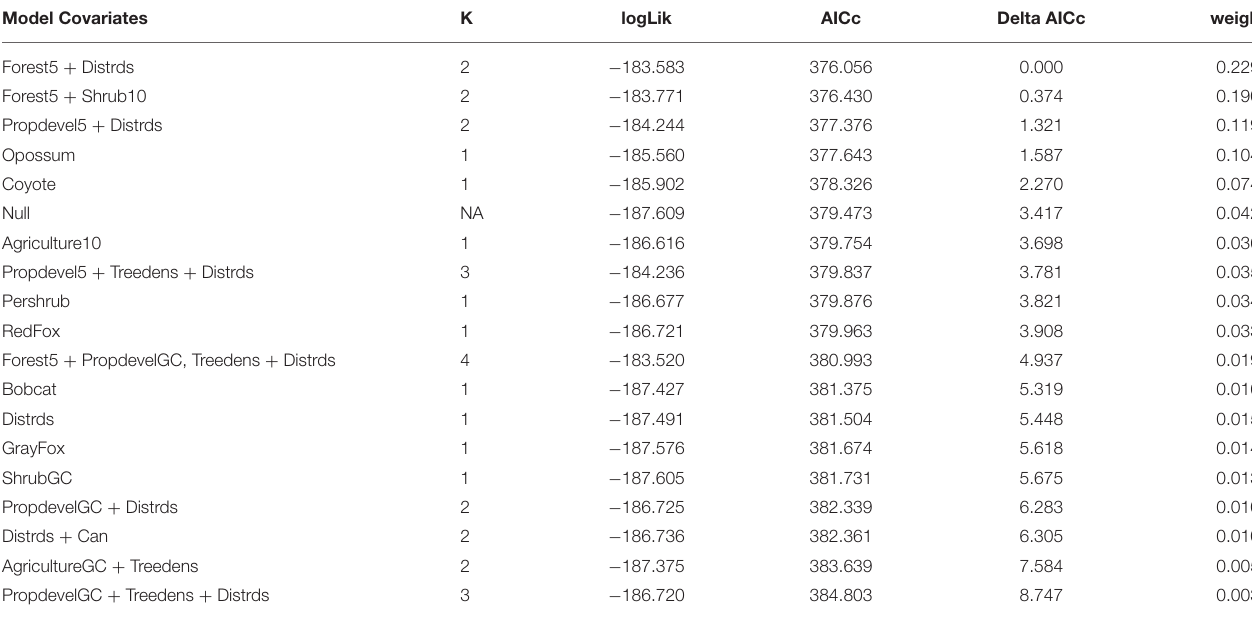
TABLE 6 | Candidate model set for P. lotor . Model